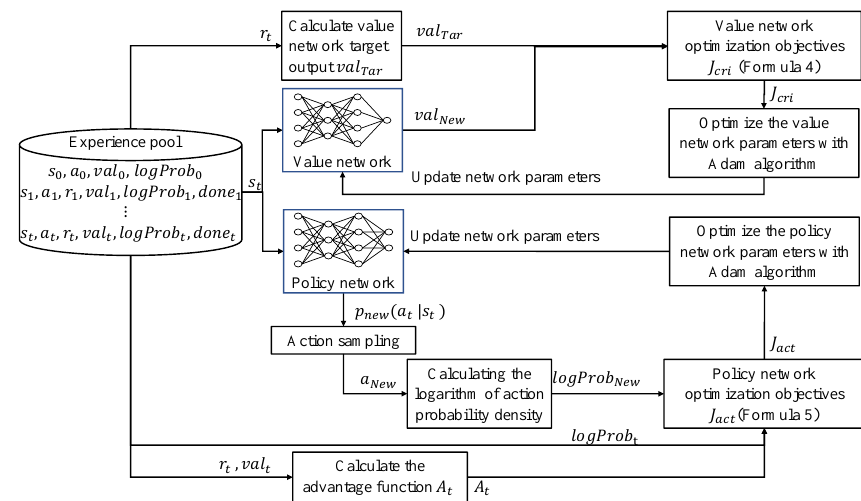
Figure 8. Experience replay and network parameters update process.